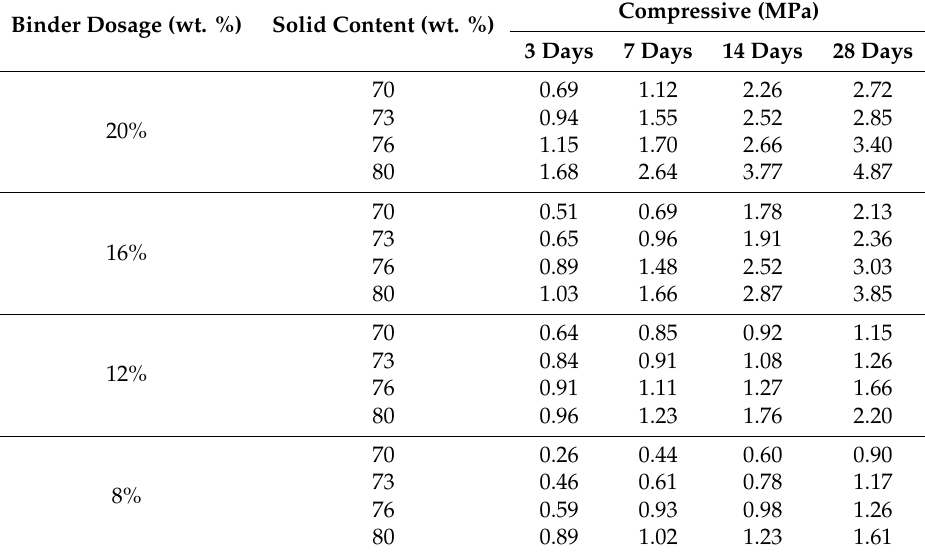
Table 6. Compressive strength of CPB